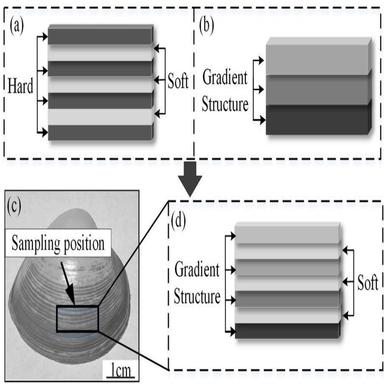
Structure diagram of laminated composites: (a) Conventional "brick-mud" interleaved composites; (b) Conventional liner arrangement FGM; (c) Physical image of white clam shell; (d) Bionic interleaved FGM.